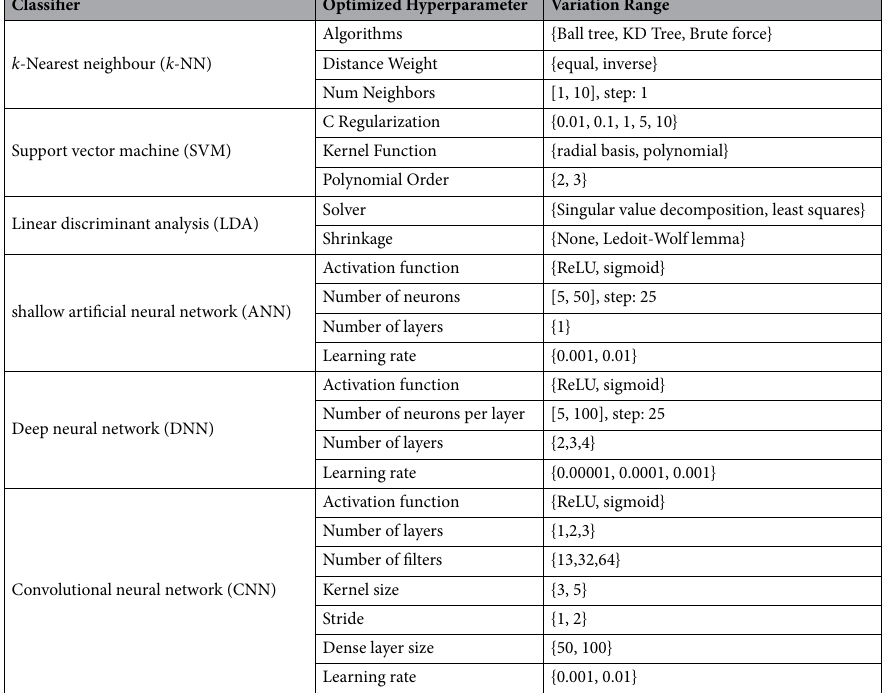
Table 1. Classifier optimized hyperparameters and variation ranges.